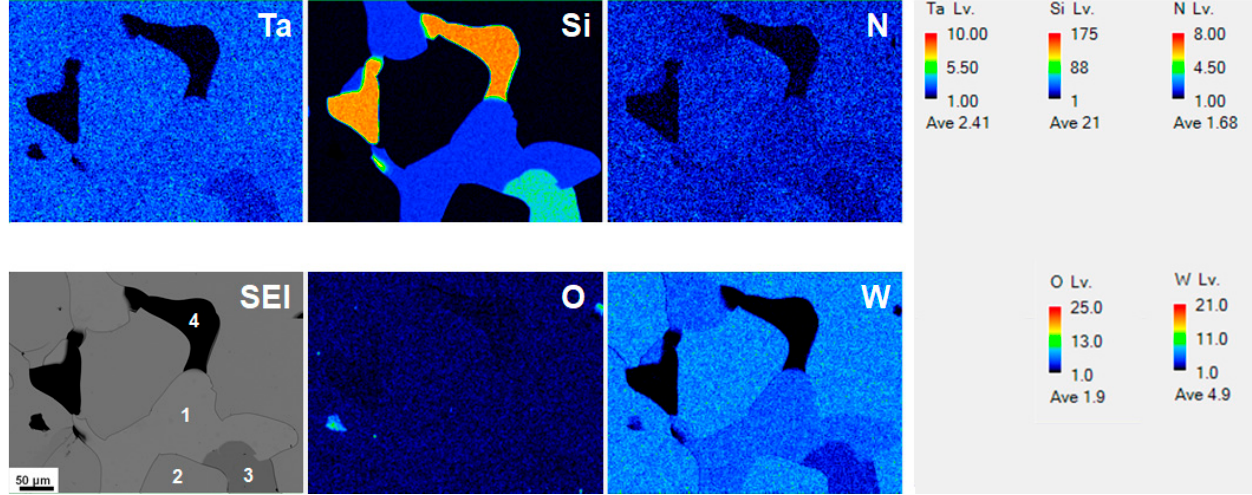
Figure 1. SEI and elemental mappings of the S1 sample with a Ta interlayer prepared on Si substrate.